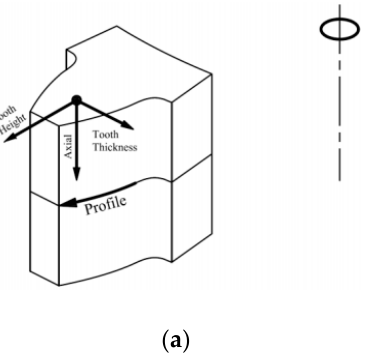
Figure 10. ( a ) Illustration of the involute profile measurement at the central cross-section; ( b ) illustration of the lead (axial) profile measurement on the pitch circle.